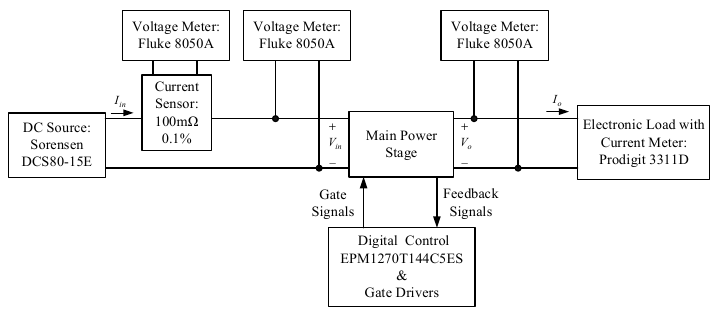
Figure 16. E ffi ciency Figure 16. Efficiency measurement.